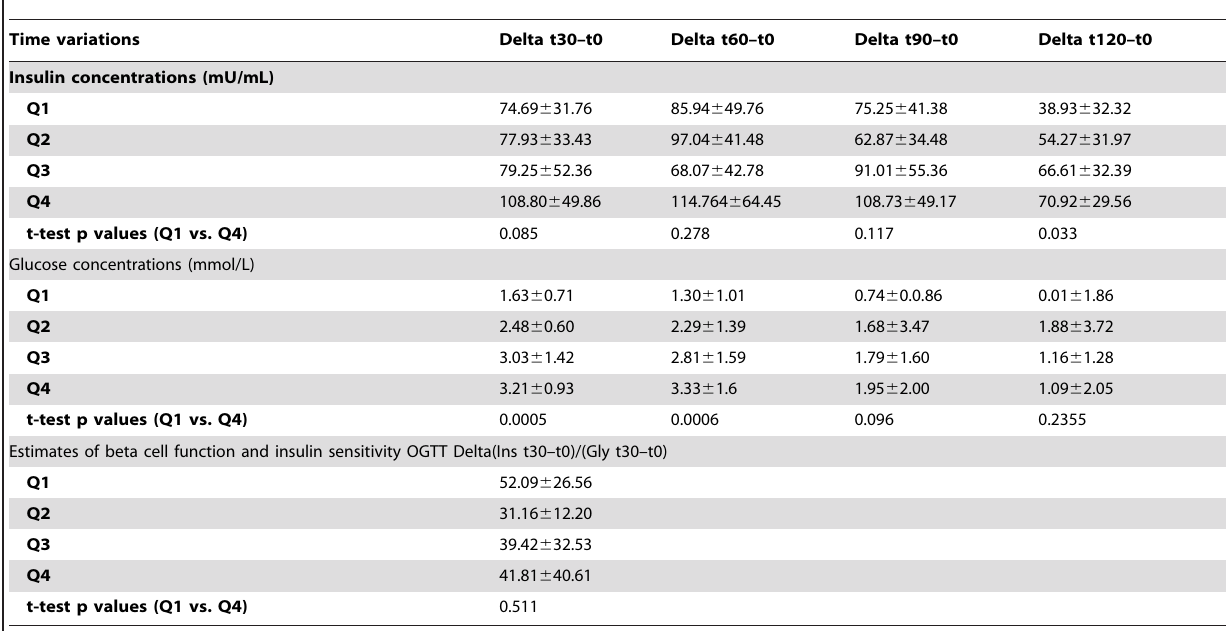
Table 2. Insulin and glucose response to oral glucose tolerance test according to intraperitoneal/abdominal fat ratio.